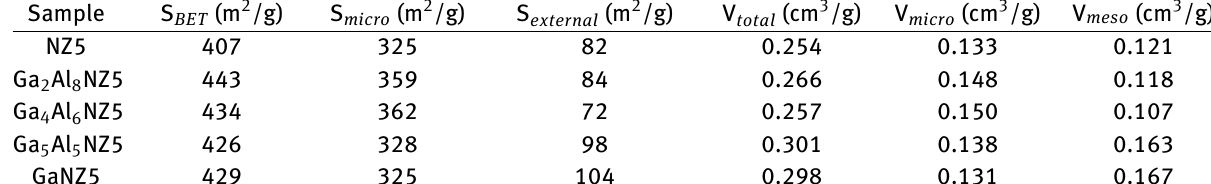
Table 4: Textural data of nano sized HZSM-5 and samples isomorphously substituted by Ga [8] Sample